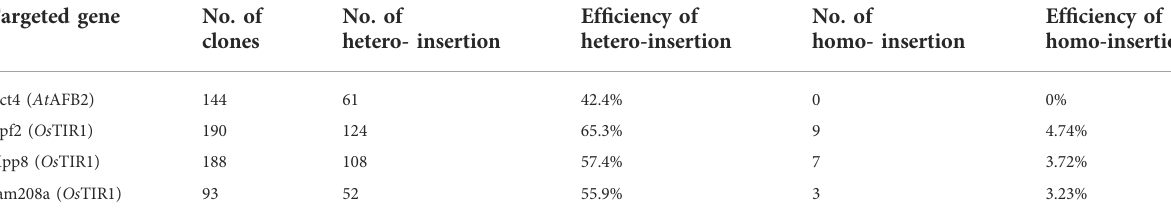
TABLE 1 Summary of gene targeting ef fi ciency using AID systems. Targeted